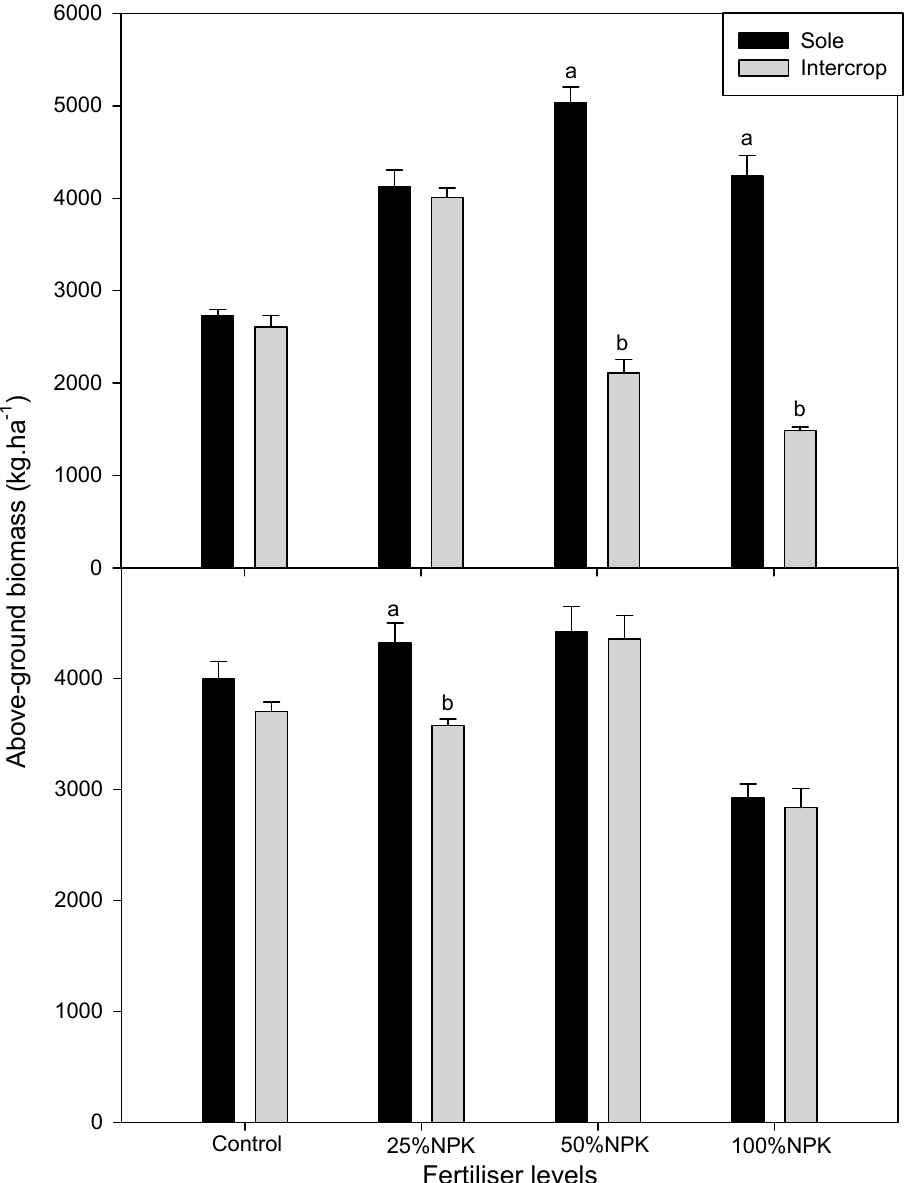
Figure 6. Two-way analysis showing the e ff ects on plant and soil P concentration on rhizosphere of Figure 6. Two ‐ way analysis showing the effects on ( A , B ) plant and ( C , D ) soil P concentration on rhizosphere above ground biomass of cowpea at four NPK levels in 2014 / 15 and 2015 / 16 seasons. Each bar represents of above ground biomass of cowpea at four NPK levels in 2014/15 and 2015/16 seasons. Each bar represents the mean ± SE (n = 4). Di ff erent letters in each fertilizer treatment shows significant di ff erences at p ≤ the mean ± SE (n = 4). Different letters in each fertilizer treatment shows significant differences at p ≤ 0.05 in 0.05 in sole or sole or intercropping.